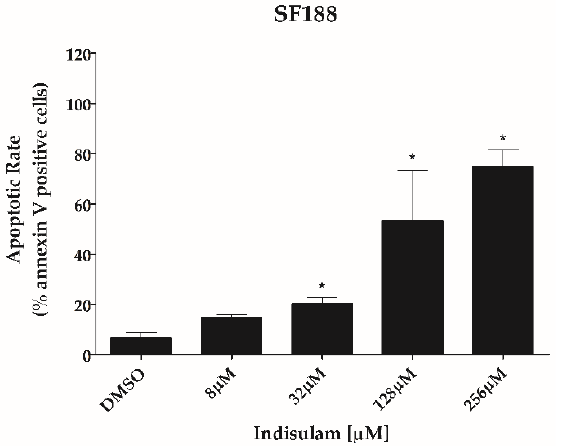
Figure 5. Indisulam induces apoptosis in pHGG cell lines. To induce hypoxia, the cells SF188 and KNS-42 were incubated for 24 h with CoCl 2 (50 µ M and 100 µ M, respectively) and then treated with different concentrations of Indisulam (0–256 µ M) for 48 h, as indicated on bar graphs. Cell death by apoptosis was assessed by annexin-V and propidium iodide and analyzed by flow cytometry. * p < 0.05 indicates a significant difference between the treated cells and the DMSO control.